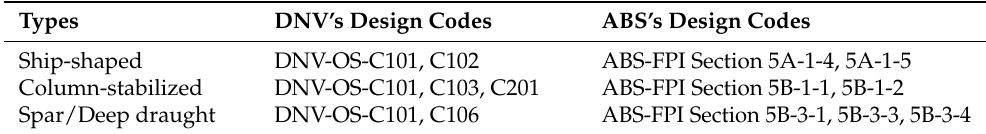
Table 2. DNV and ABS design codes of different classification types for offshore fish farming.